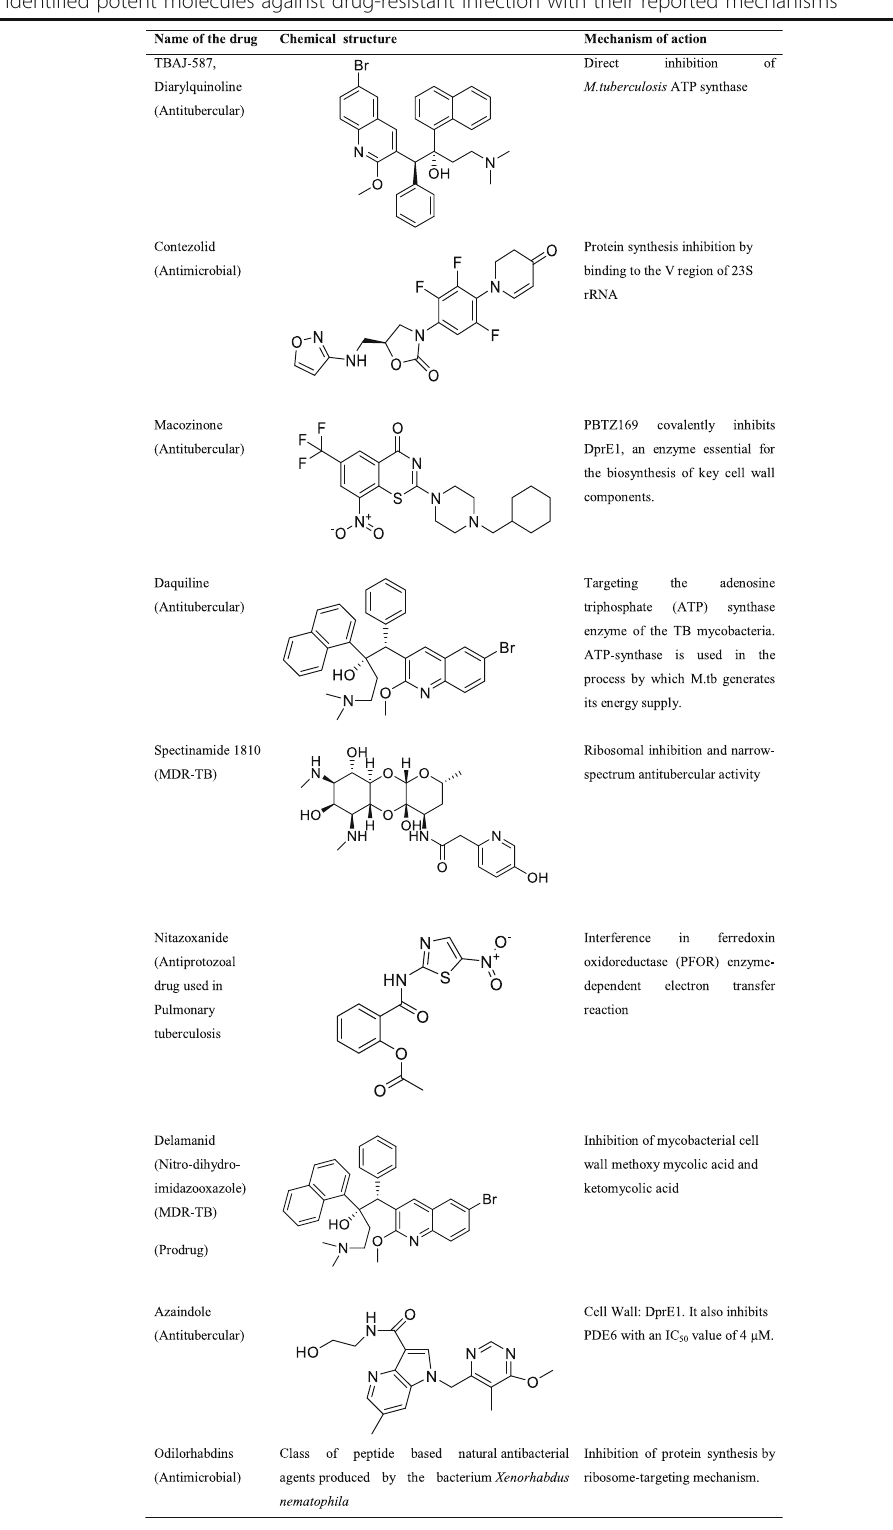
Table 6 Newly identified potent molecules against drug-resistant infection with their reported